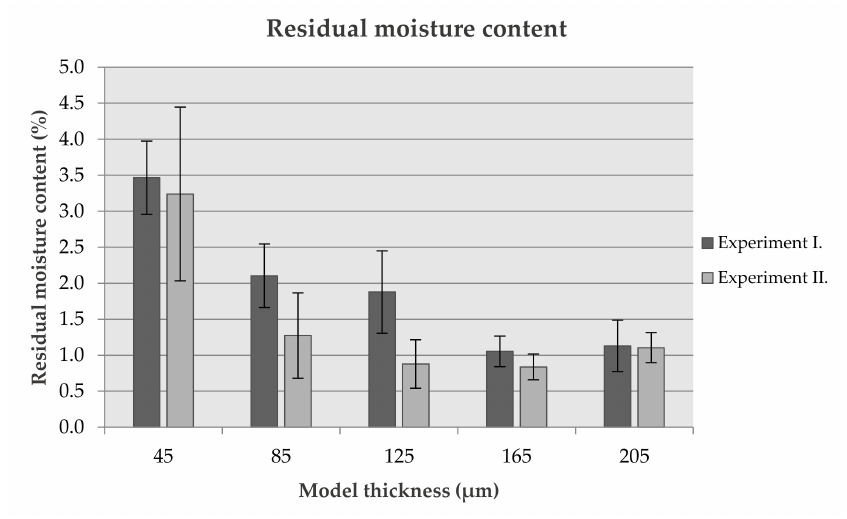
Figure 1. Graph of residual moisture content